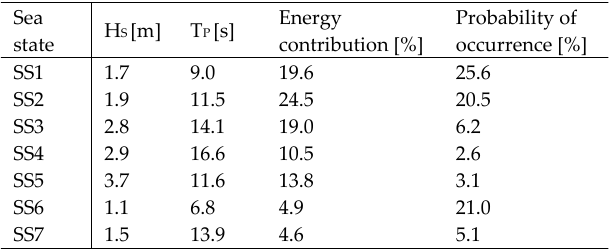
T ABLE I C HARACTERIZING PARAMETERS OF THE SELECTED SEA STATES